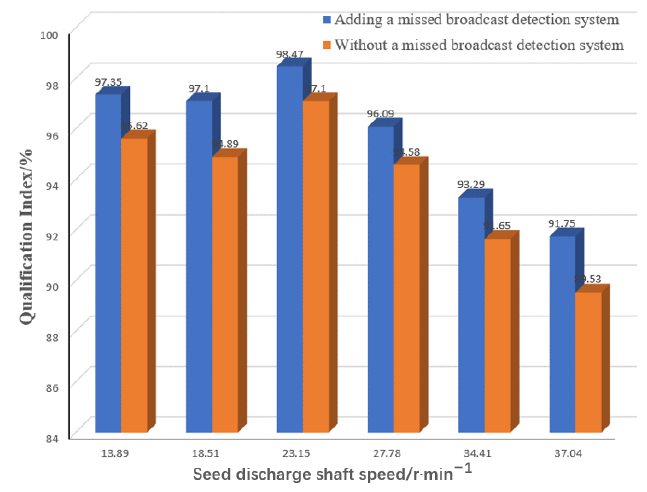
Figure 15. Analysis diagram of test results.